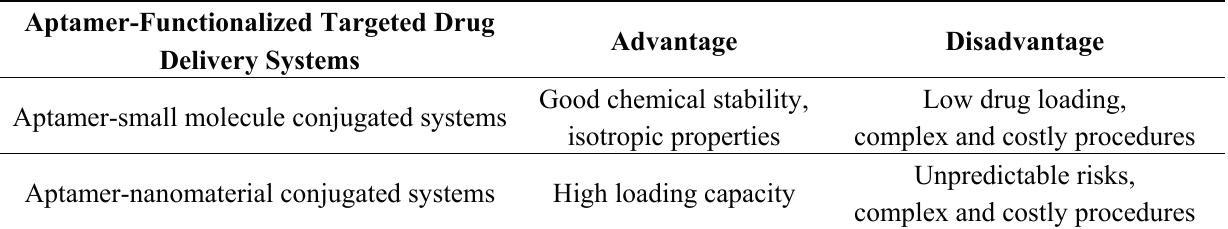
Table 2. The advantages and disadvantages of the aptamer-functionalized targeted drug delivery